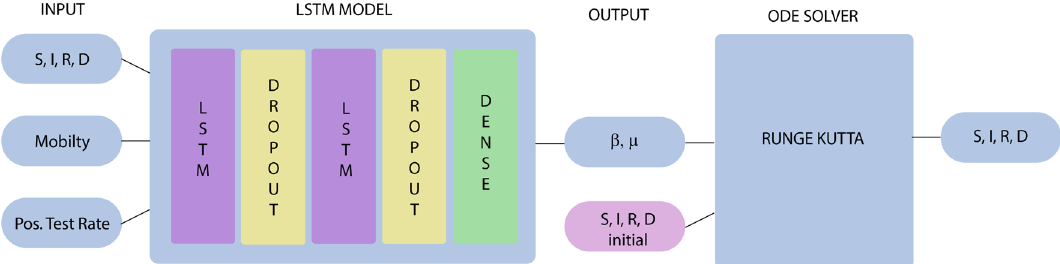
Figure 9. A description of the combined SIRD–LSTM model structure with Covid-19 community mobility (mobility) and positive test rate (Pos. Test Rate) to generate forecasts of time varying parameters (β , µ) . The ODE solver based on the Runge–Kutta fourth order method makes use of the predicted parameters in the numerical